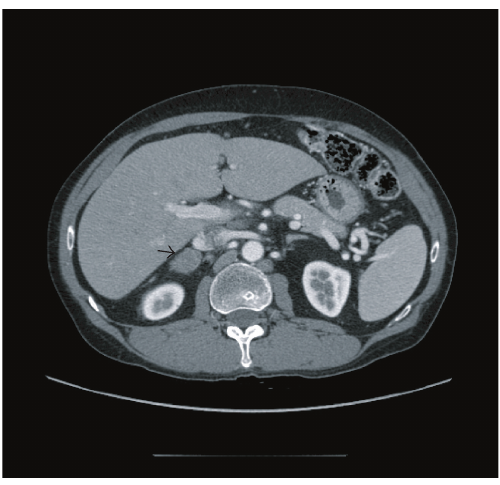
Figure 1: Axial C.T scan image with intravenous contrast. There is an expansile oval mass in the right adrenal gland with soft tissue density